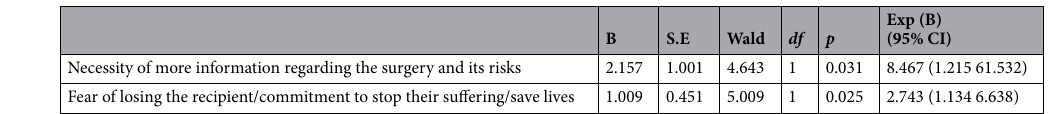
Table 5. Logistic regression for the model of pre-donation assessment (n = 59) † . † One donor had a missing value on Fear of losing the recipient/commitment to stop their suffering/save